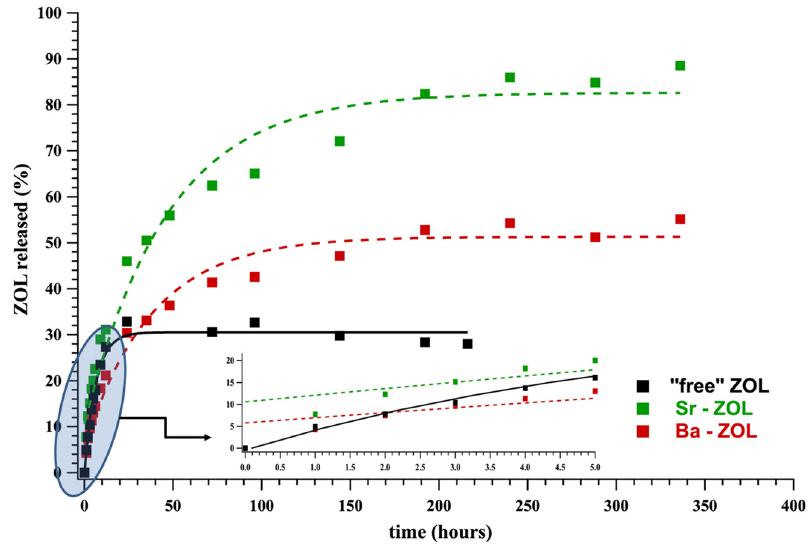
Figure 5. ZOL release curves from Sr– and Ba–ZOL containing tablets and comparison with the “free” ZOL system. Table 3. Kinetic data for the drug release from tablets with “free” ZOL, Sr–ZOL and Ba–ZOL.